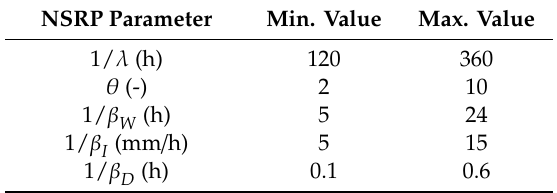
Table 1. Assumed parameter ranges of variation for the adopted basic version of NSRP model. NSRP Parameter Min.